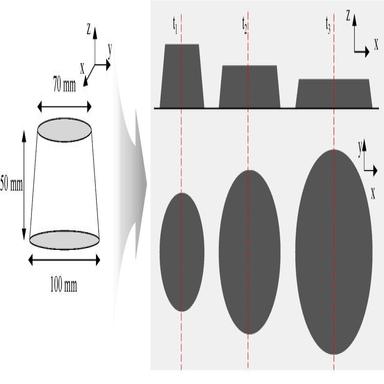
Mini-slump test using a conical mold.